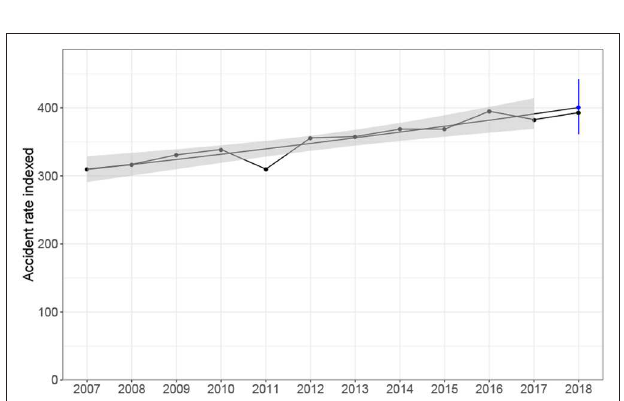
FIGURE 3 | 95% prediction range (blue) for bike accidents.